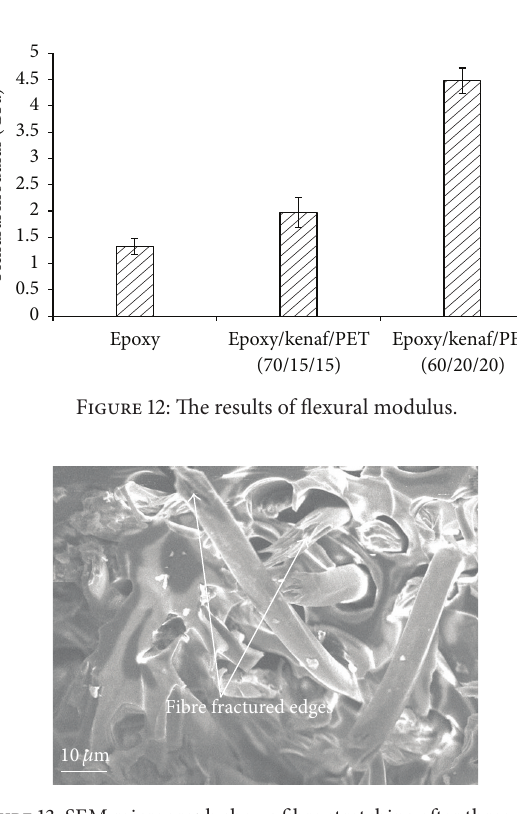
Figure 13: SEM micrograph shows fibre stretching after three-point bending